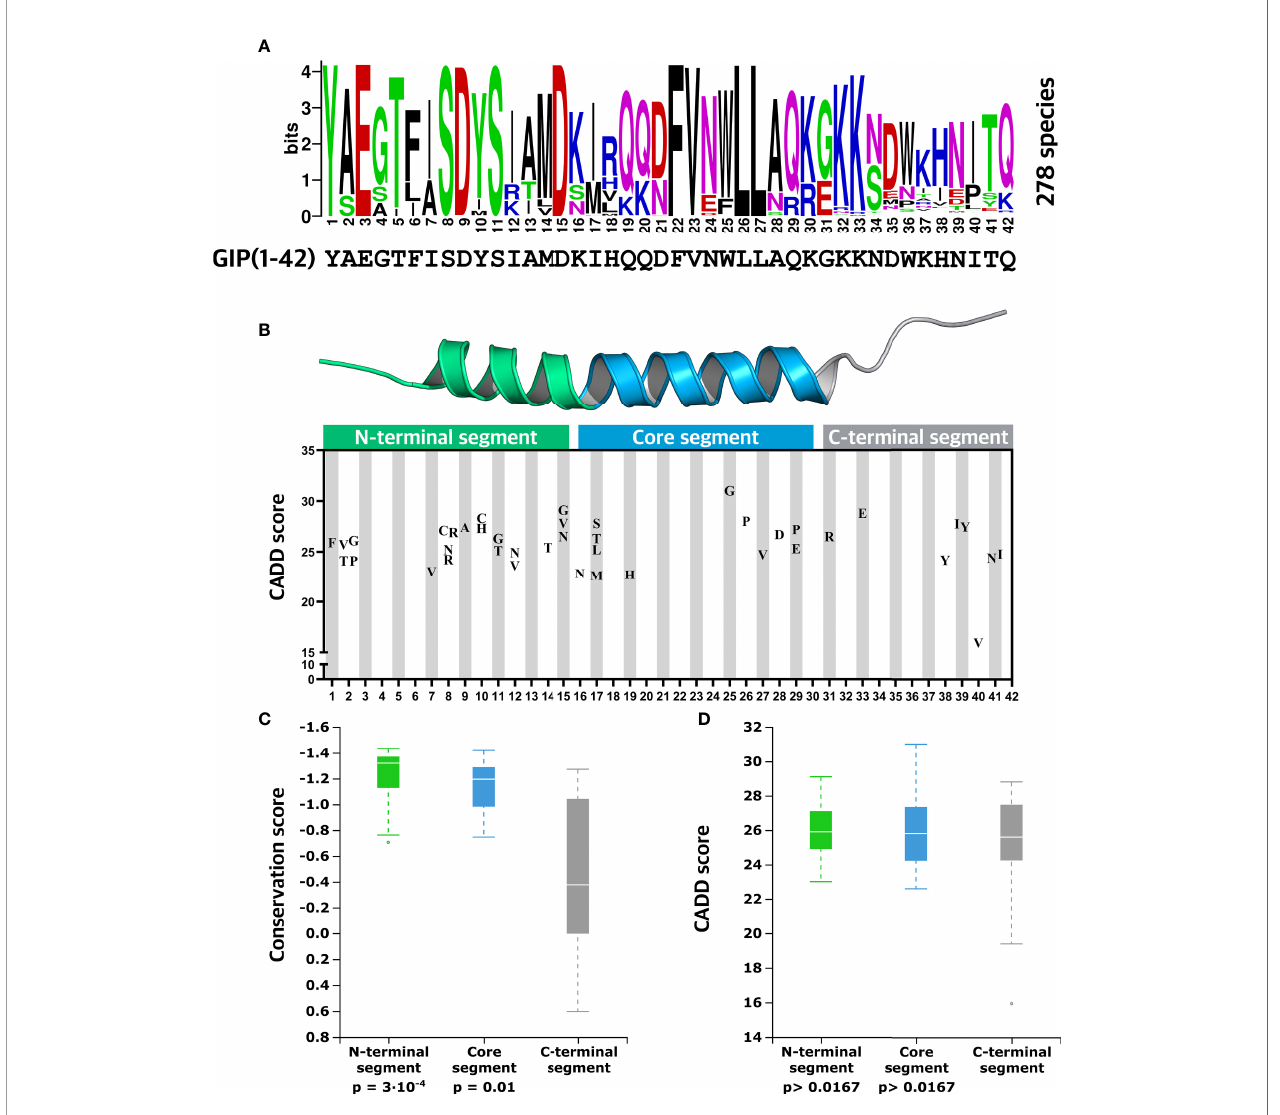
FIGURE 4 | Evolutionary insights into essential GIP peptide positions. (A) Amino acid conservation logo plot determined by multiple sequence alignment using GIP sequences from 278 different species. The overall height over the letter stack indicates sequence conservation in the speci fi c position, whereas the height of each letter indicates the relative frequency of each amino acid at that speci fi c position. (B) Distribution of missense variants in the GIP peptide is displayed along with predicted deleteriousness using the CADD (Combined Annotation-Dependent Depletion) score. (C) Comparisons of mean conservation score between the GIP peptide segments show that the N-terminal segment (positions 1-15) and core segment (positions 16-30) display a signi fi cantly higher degree of conservation compared to the C-terminal segment. (D) Aggregated mean CADD scores (abbreviation of Combined Annotation-Dependent Depletion, predicting variant deleteriousness) for individual GIP peptide segments show that variants in the GIP sequence exhibit similar mean CADD score independent of the segment they are located in. Statistical signi fi cance between sample means was assessed using the Mann-Whitney U test (p-value threshold